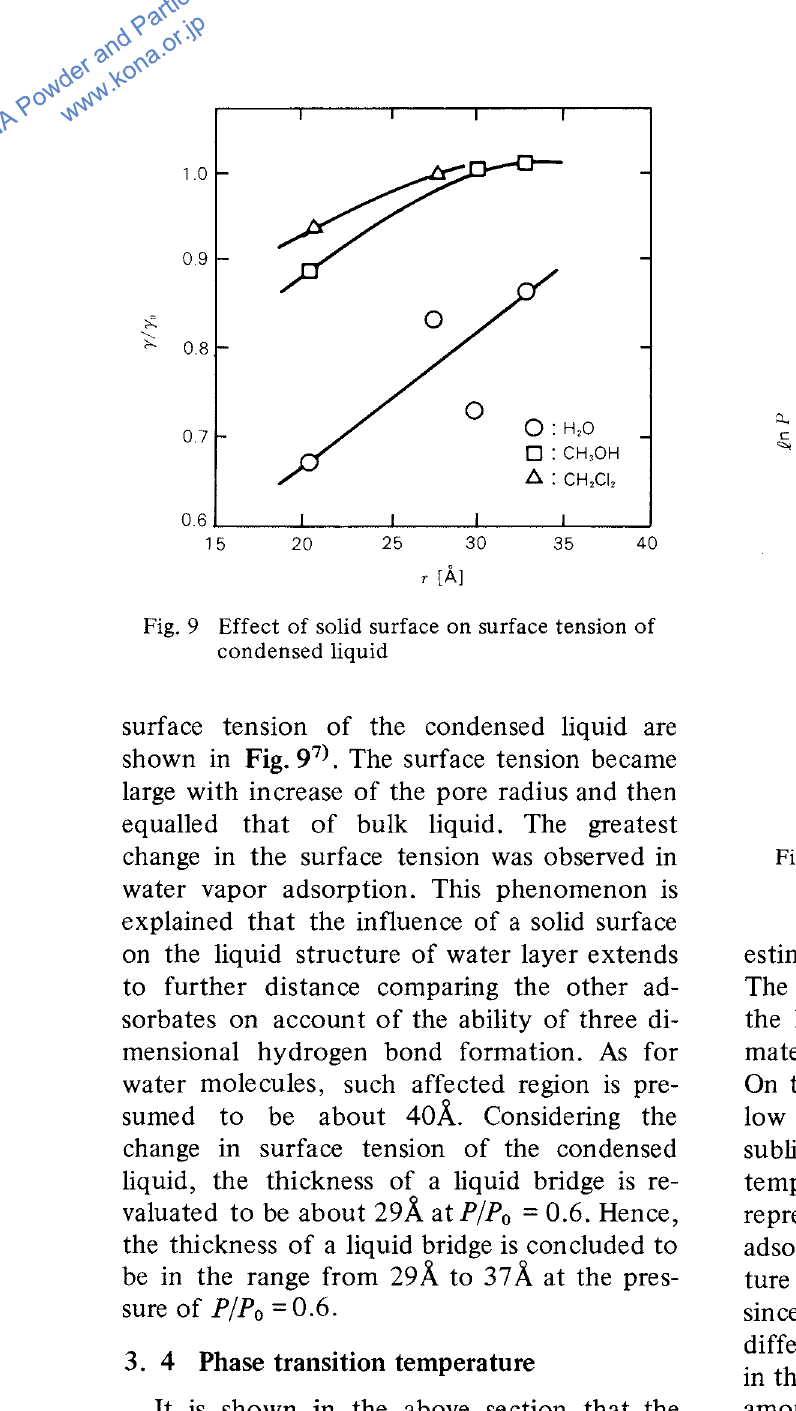
Fig. 9 Effect of solid surface on surface tension of condensed liquid